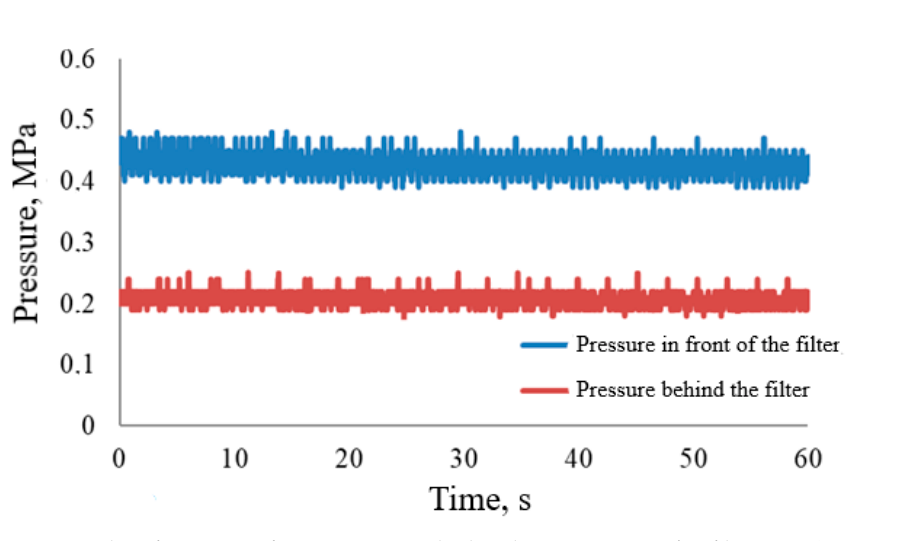
Figure 3. Plot of pressure of uncontaminated oil with MANN W950/26 filter at 30 ◦ C.